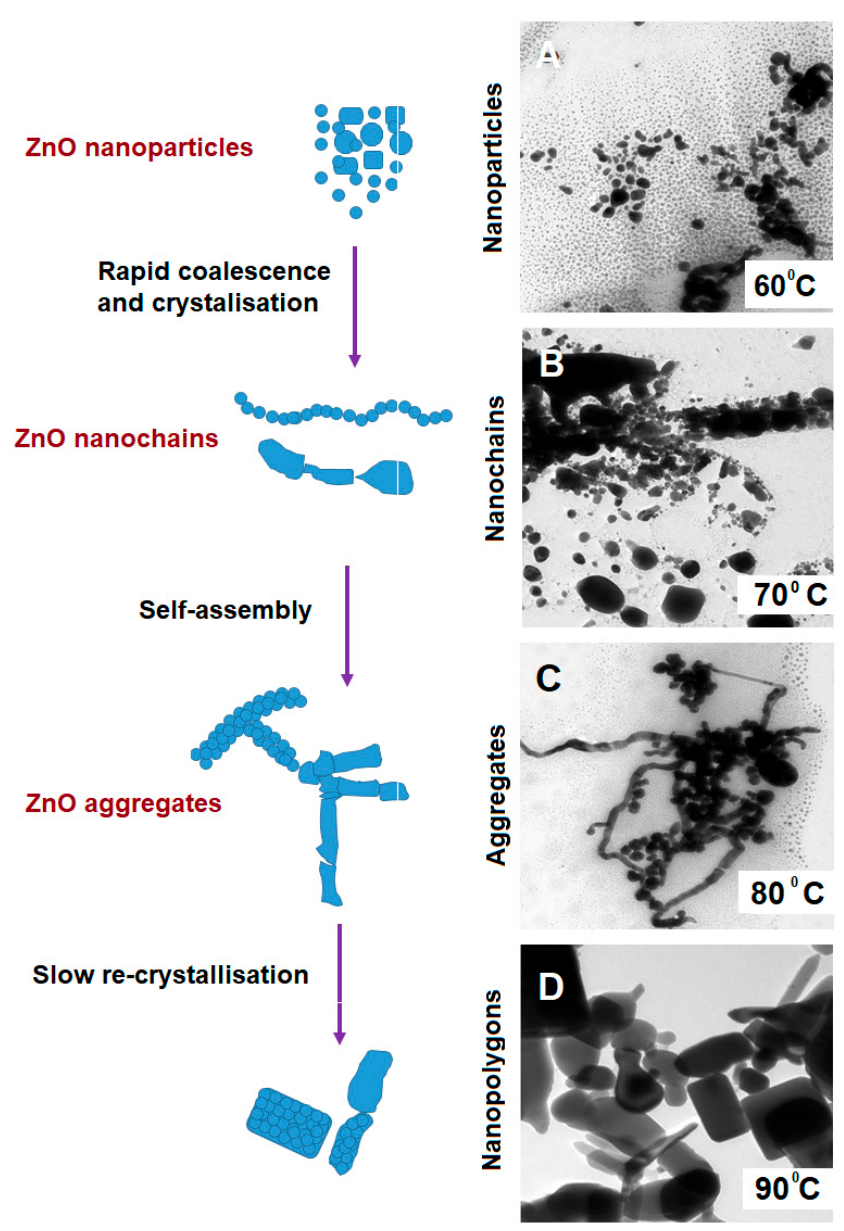
Figure 3. Schematic illustration on the spontaneous growth of ZnO nanoparticles under the governance of the OA mechanism and the corresponding TEM micrographs on ZnO microstructures. Noted that the rapid coalescence occurs as the process changes from ( A ) to ( B ) in the increase of heat. As the process continues, the self assembly occurs ( C ) and further caused slow re-crystallisation as the heat is increased ( D ).